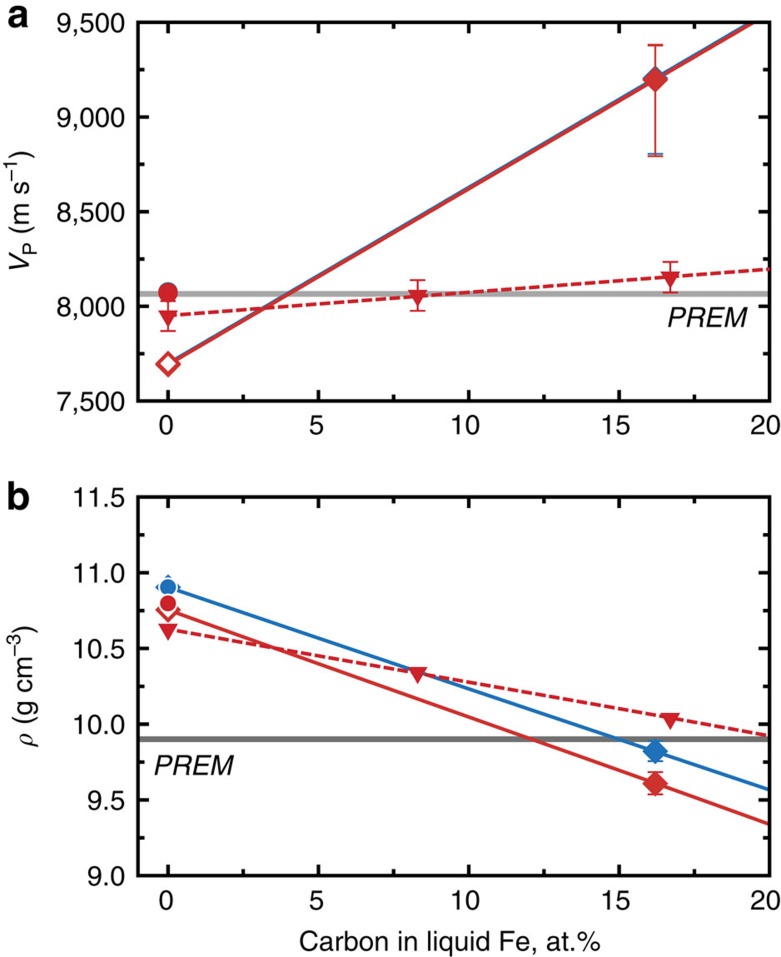
Effect of carbon on the velocity and density of liquid Fe at 136 GPa.(a) Velocity and (b) density for liquid Fe84C16 at TCMB=4,300 K (red) and 3,600 K (blue). Present results (closed diamonds, solid curves) are compared with theoretical calculations34 (triangles, broken curve). The data for pure Fe are from shock compression study8 (open diamonds) and theoretical calculations26 (closed circles). PREM denotes seismological observations35 at the CMB.